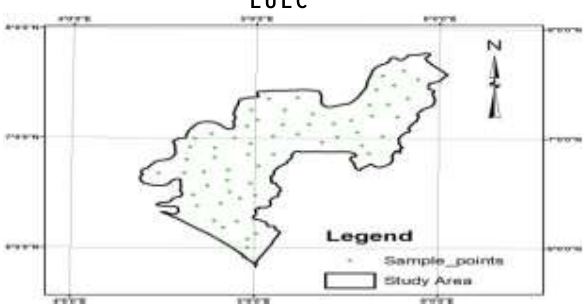
Figure 3: The Location of sample sites for the analysis of surface temperature across various LULC over Ondo State in the different